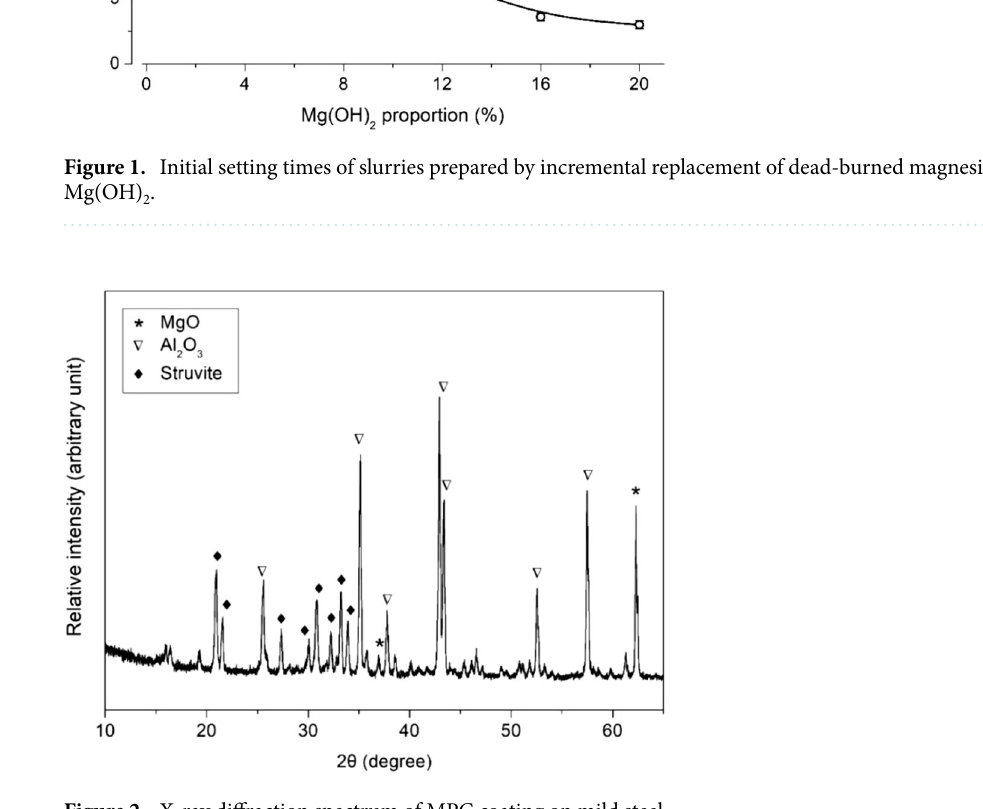
Figure 2. X-ray diffraction spectrum of MPC coating on mild